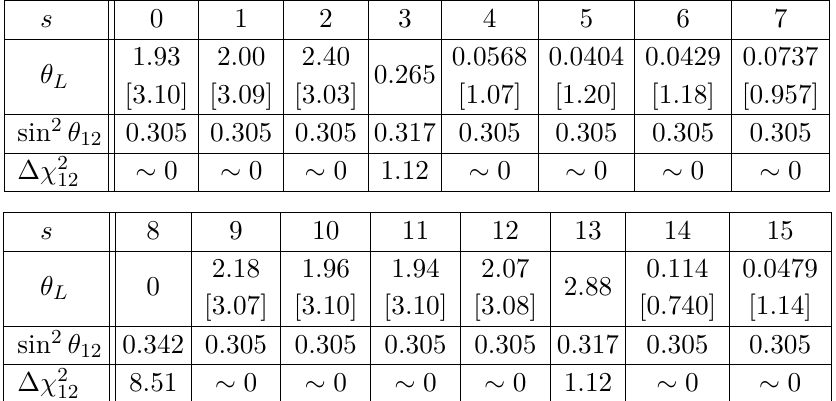
Table 2 . Case 3 a) Results for the smallest value of the index n , n = 16 , and m = 1 together with sin 2 θ 0 . 0254 and sin 2 θ 0 . 613 . For m = 15 the same results are found up to sin 2 θ 13 ≈ 23 ≈ and θ being replaced by π − θ (leaving aside very minor differences due to the fit). We display the L L contribution to ∆ χ 2 arising from the fitting of the solar mixing angle θ masses with NO. We write ∼ 0 when ∆ χ 2 < 10 − 3 . The presence of a second best fit value for θ L is 12 indicated in square